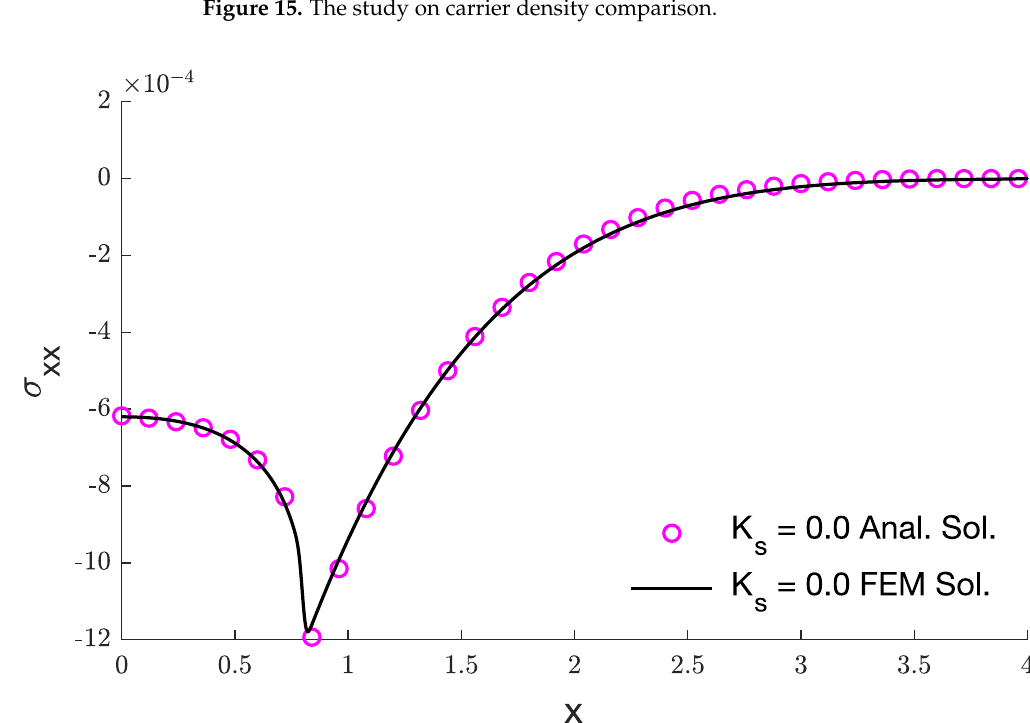
Figure 15. The study on carrier density comparison.